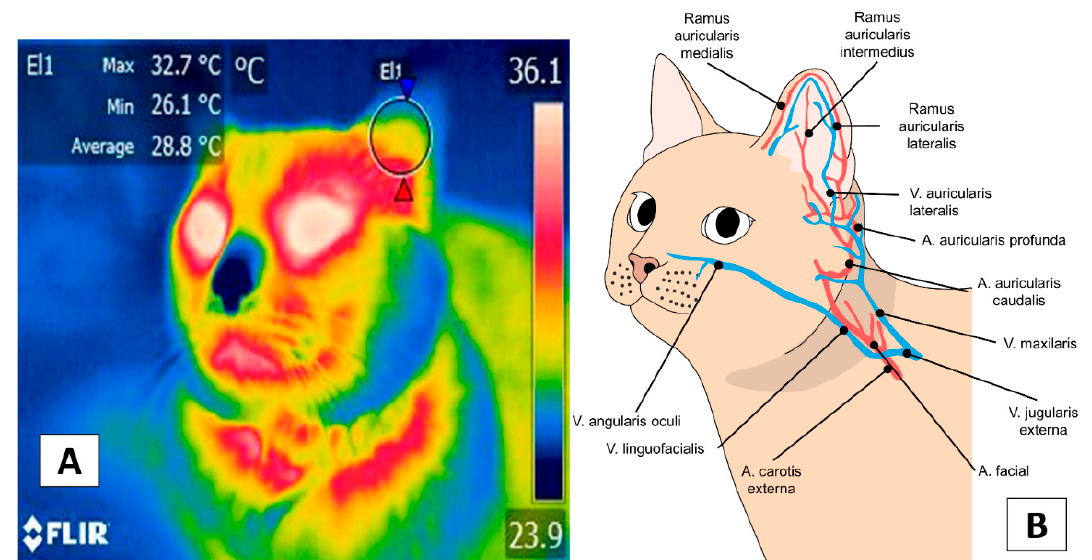
Figure 2. The thermal window of the ear. This window considers the auricular region marking a circle of approximately 2 cm (El1) to obtain the irradiated temperature of the tympanic membrane or the inner ear ( A ). This region presents irrigation from the deep auricular artery and three branches that allow thermal exchange with the environment ( B ) through vasomotor changes. Thermal images obtained using a FLIR thermal camera.